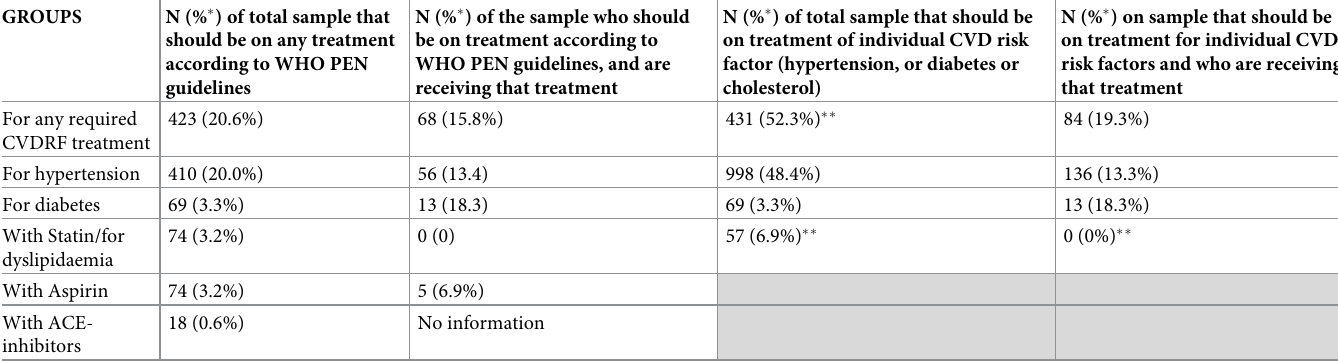
Table 3. People that should be treated according to PEN guidelines or diagnostic criteria, and proportions on treatment currently n (weighted percentages) (n = 1892). GROUPS